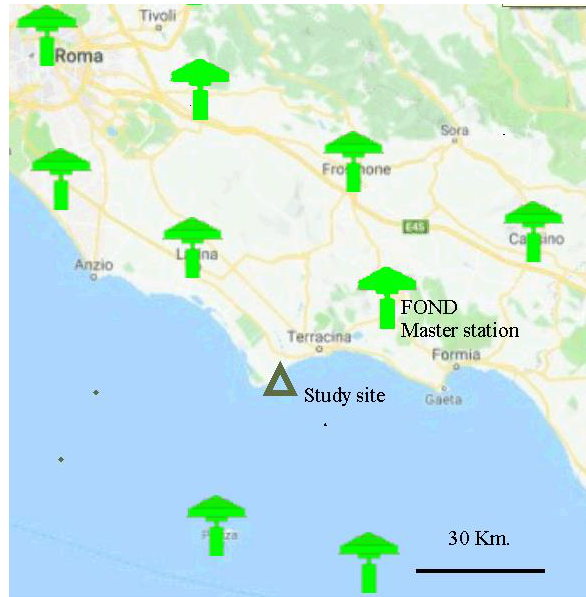
Figure 5. The study site and the permanent stations used to process the virtual station; from gnss-regionelazio.dyndns.org, redesigned.